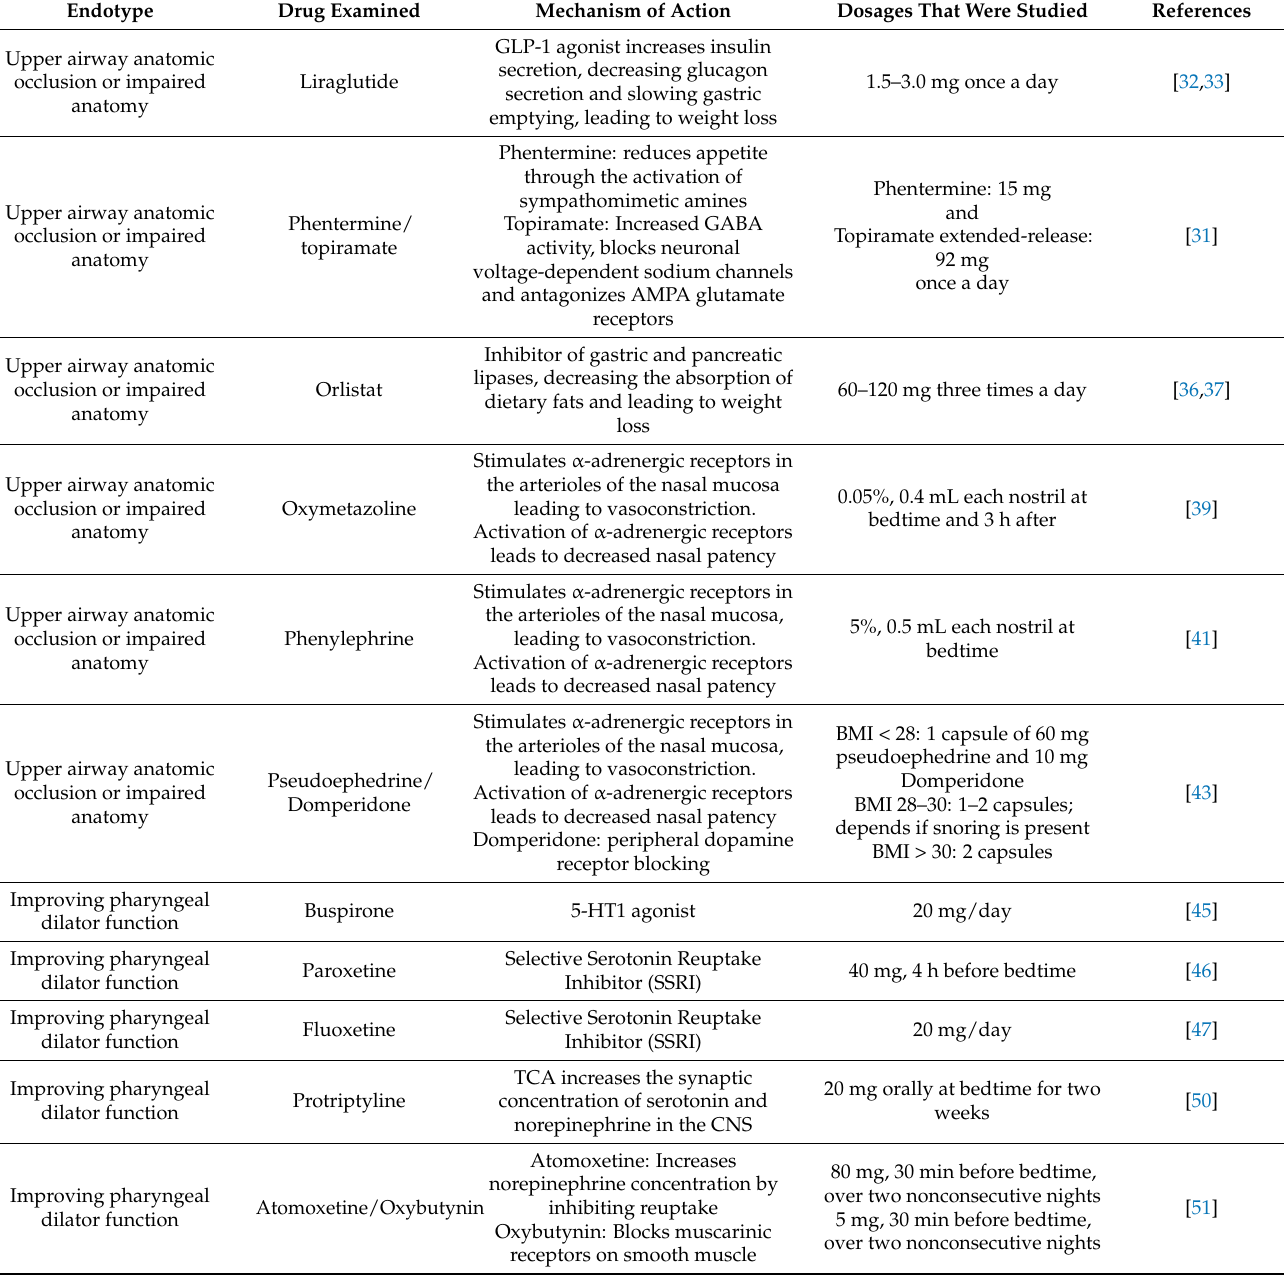
Table 1. Potential Medication Options and Proposed Mechanism of